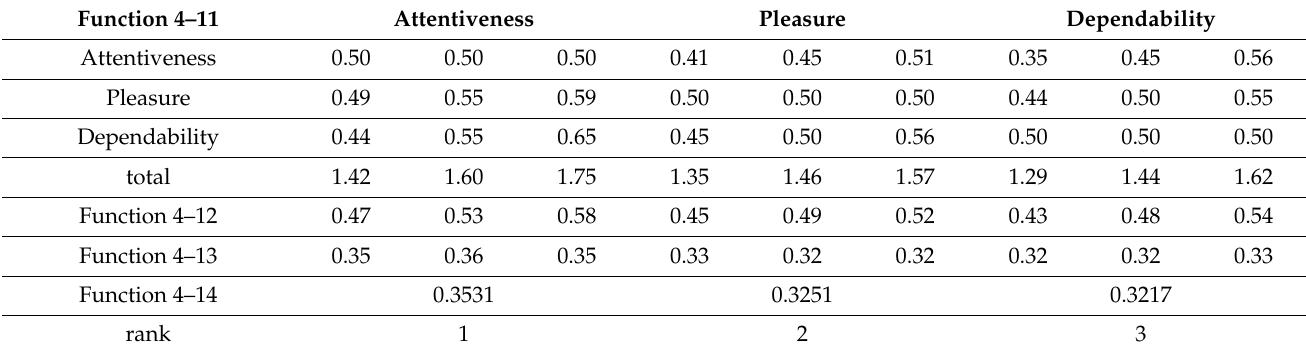
Table A18. Hotels’ weights of attributes of the emotional value.